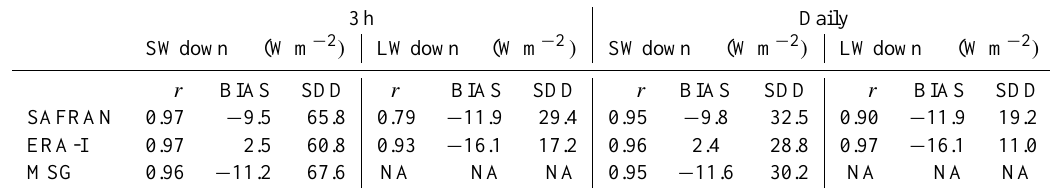
Table 5. Evaluation of SAFRAN, ERA-I and MSG downwelling shortwave radiation (SWdown) and downwelling longwave radiation (LW- down) against measurements, over the 12 October 2004–25 June 2012 period, at 3h and daily time steps. The SWdown performances of all the data sets were evaluated considering only the time steps with valid MSG SWdown, which represents 93% of the period. 3h